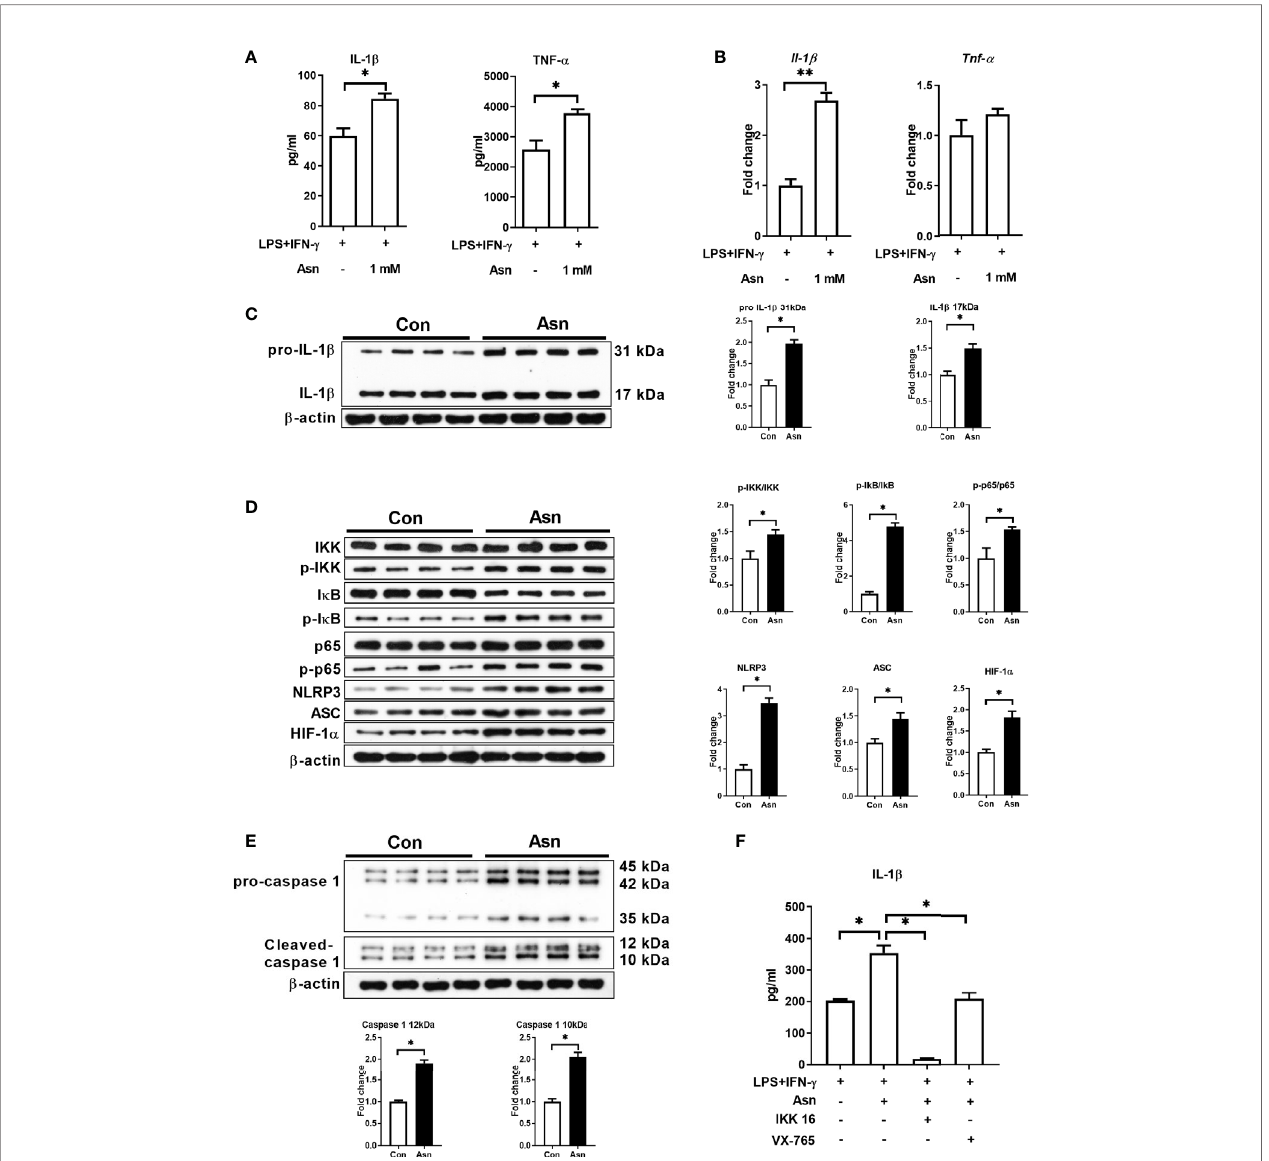
FIGURE 4 | Asparagine promotes the production of interleukin 1 b (IL-1 b ) and the activation of signal pathways in macrophages. (A) IL-1 b and tumor necrosis factor alpha (TNF- a ) secretion in M1 macrophages and asparagine-treated M1 macrophages ( n = 4 – 5). (B) mRNA expressions of IL-1 b and TNF- a in M1 macrophages and asparagine-treated M1 macrophages ( n = 6). (C – E) Protein abundance of IL-1 b , I k B kinase (IKK), p-IKK, I k B, p-I k B, p65, p-65, hypoxia-inducible factor-1 a (HIF- 1 a ), Nod-like receptor protein 3 (NLRP3), apoptosis-associated speck like protein containing a caspase recruitment domin (ASC), and caspase-1 in macrophages ( n = 4). (F) IL-1 b secretion in M1 macrophages with asparagine combined with IKK16 or VX-765 ( n = 3). Data were analyzed with unpaired t -test (A – E) or with one- way ANOVA (F) . Error bars represent the mean ± SEM. * p ≤ 0.05, ** p ≤